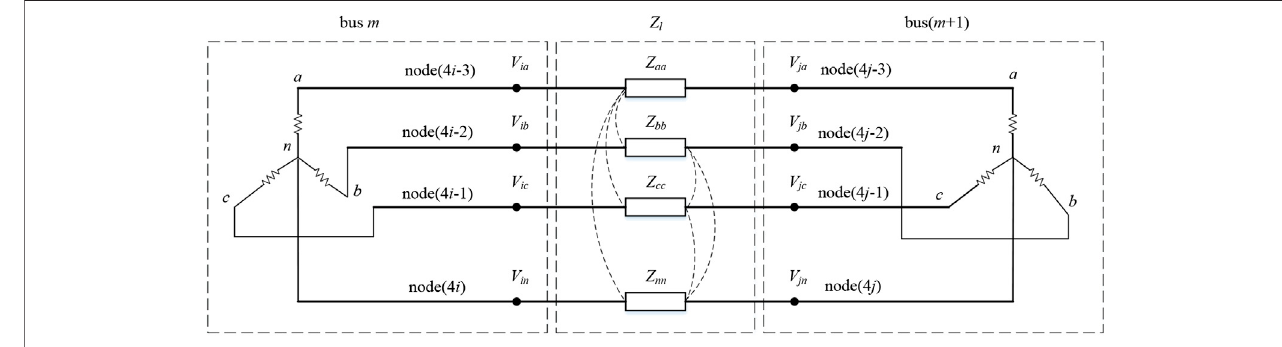
FIGURE 1 | Model of the three-phase four-wire low voltage distribution